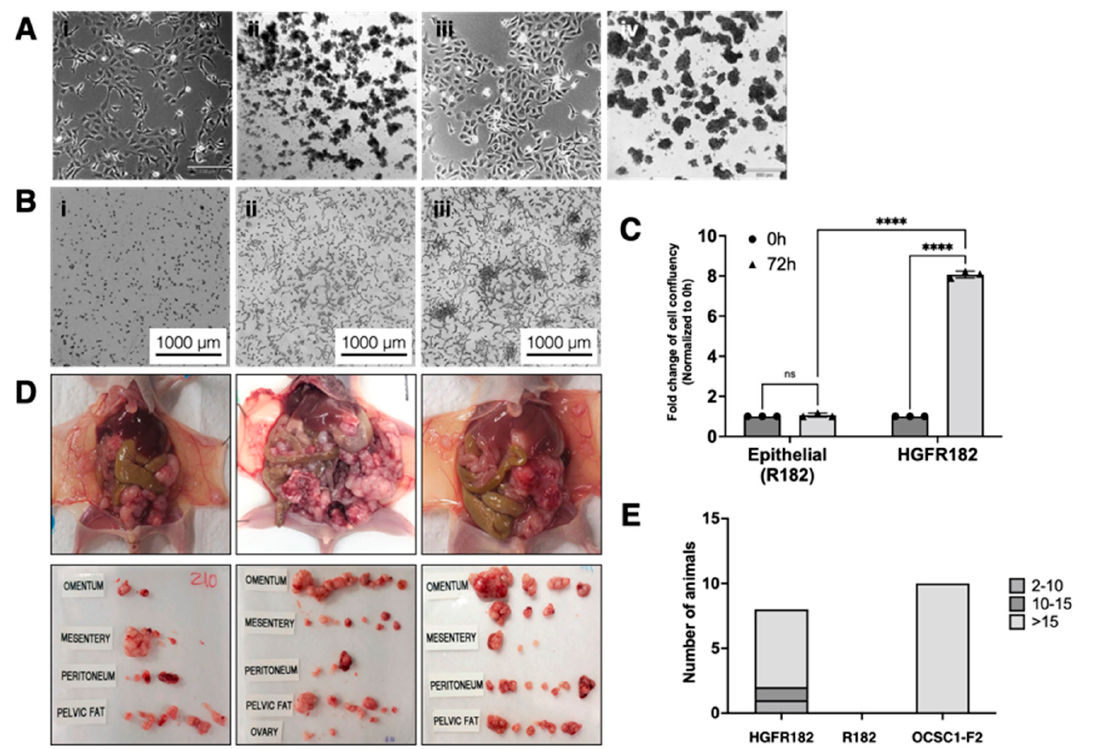
Figure 8. Generation of the HGF-treated E/M hybrid cells and their characterization. (A) Cellular images of (i) monolayer R182 cells post 80 ng/mL rHGF treatment for 48 h, (ii) R182 cells post 80 ng/mL rHGF treatment for 48 h seeded in ULA plate with the addition of 80 ng/mL rHGF cultured for 7 days, (iii) cells from condition (ii) plated back in the tissue culture-treated surface as a monolayer (referred as HGFR182), (iv) cells from the condition shown in (iii) cultured in the ULA plate without the addition of rHGF for 7 days. ( B ) Invasion assay of HGFR182 (i) 0, (ii) 24, and (iii) 72 h timepoints. (C) Quantification of the invasion assay presented as the fold change of cell confluency normalized to cells in 0 h (time of seeding). Bars represent the means ± SEM; p-value **** < 0.0001, n.s. = non-significant. Two-way ANOVA was used to define the p-value. (D) Tumorigenicity assay of the HGFR182 cells shown in the three representative animals 33 days following the inoculation of HGFR182 cells and three images of the collected macroscopic tumor implants from the repre- sentative three animals. (E) Bar plot of the number of animals with either 2–10, 10–15, and >15 tumor